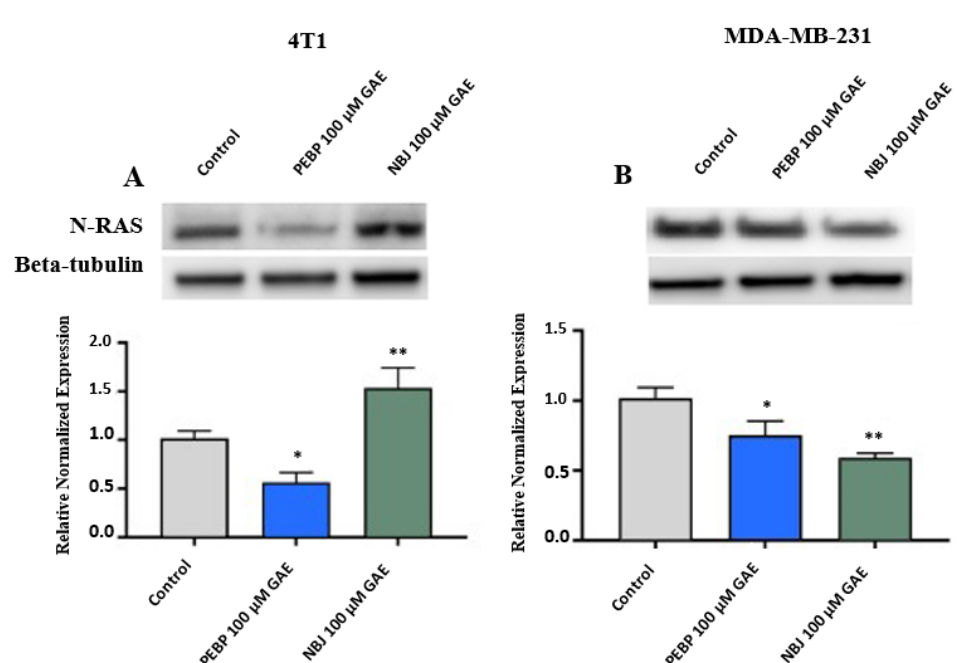
Figure 4. Relative expression of N-RAS in ( A ) 4T1 and ( B ) MDA-MB-231 cells exposed to 100 µM gallic acid equivalent (GAE) of either polyphenol-enriched blueberry preparation (PEBP) or non-fermented blueberry juice (NBJ) for 24 h. The control consisted of using the same vehicle media used for treatment groups. Western blot images are from one representative experiment. One-way ANOVA and Bonferroni’s post-hoc tests were used to compare groups. All values are mean ± SEM of 3 separate experiments. * p < 0.05 and ** p < 0.01 vs. control.